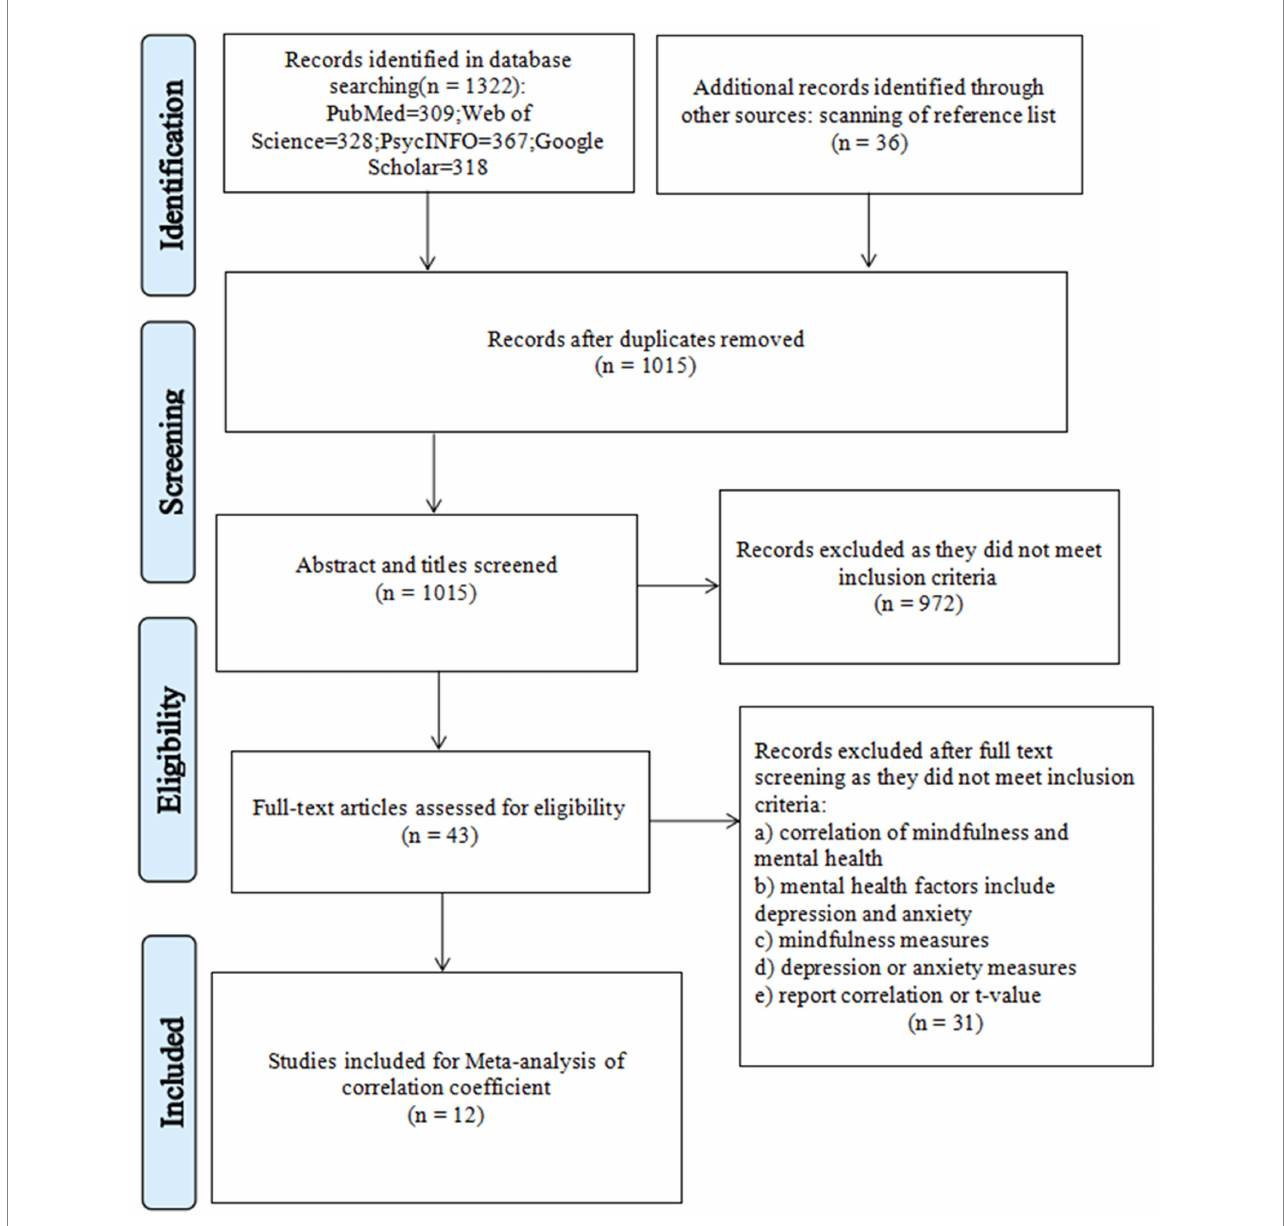
FIGURE 1 Flow diagram for the search and inclusion